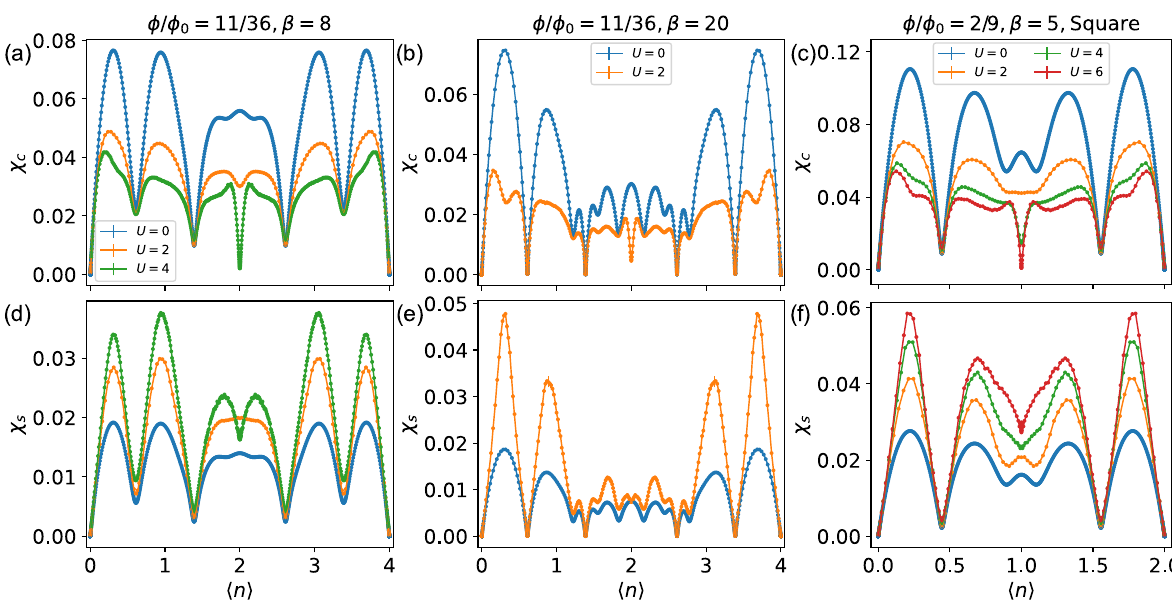
Fig. 3 Compressibility and spin correlation at a speci fi c magnetic fl ux. The fi rst row shows the charge correlation at varying interaction strength with different fi xed parameter sets. Panel ( a ) and ( b ) are for the honeycomb lattice at ϕ / ϕ 0 = 11/36, while panel ( c ) is for the square lattice at ϕ / ϕ 0 = 2/9. The corresponding temperatures are ( a ) β = 8/ t , ( b ) β = 20/ t , and ( c ) β = 5/ t sq ( t sq is the nearest neighbor hopping for the square lattice). Panels ( d – f ) in the second row show the corresponding spin correlation and shares the same legend as does the fi rst